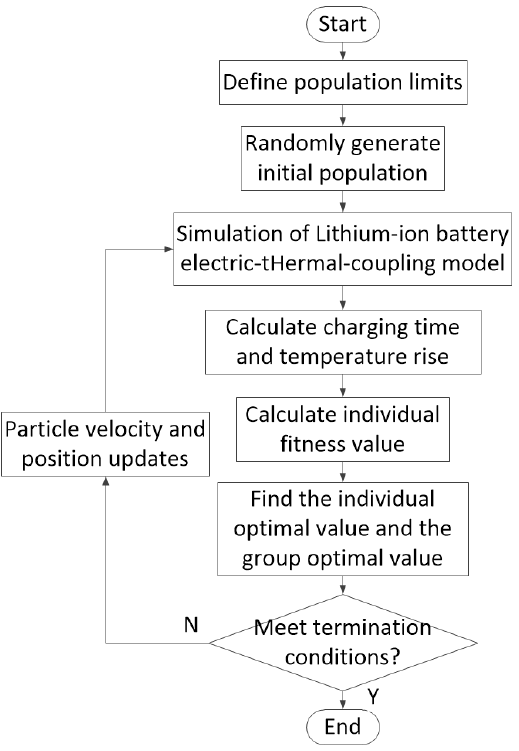
Figure 6. Flowchart of optimized charging strategy based on the particle swarm